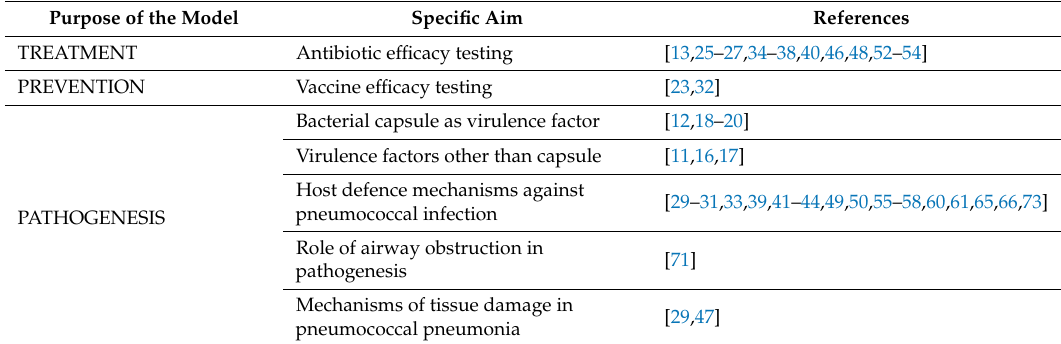
Table 2. Summary of the specific aims of the mouse models cited in the present